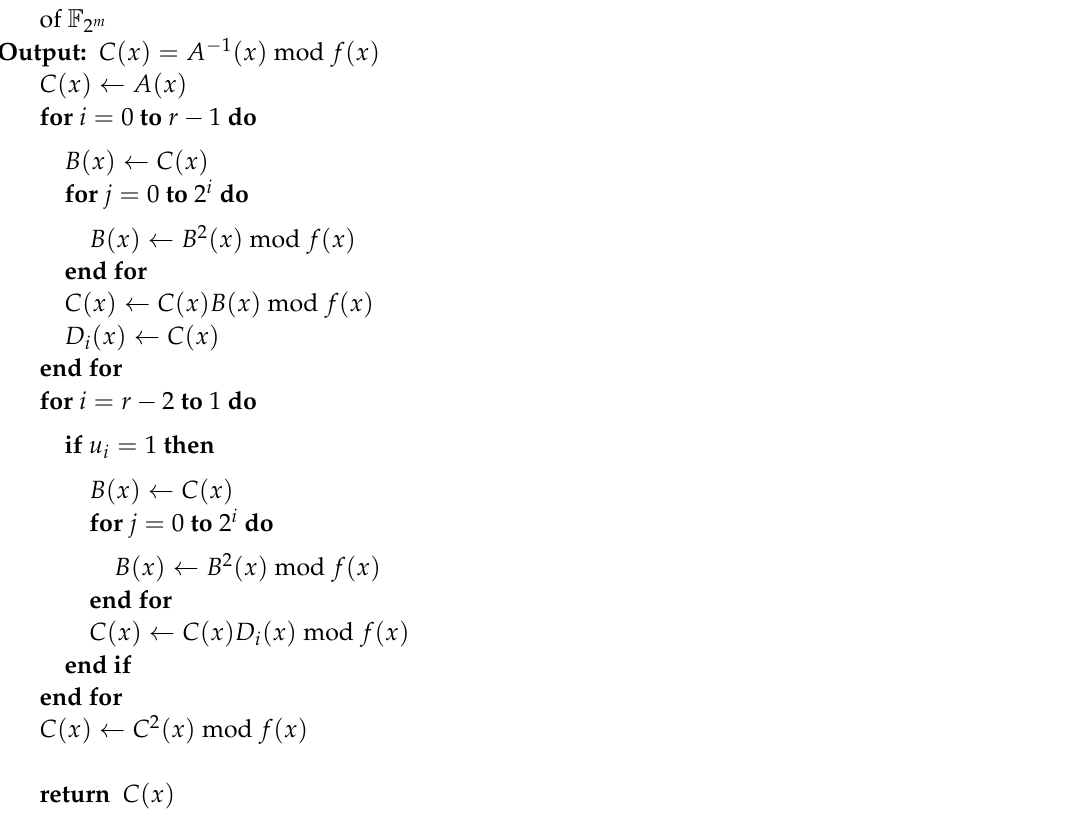
Algorithm 3 Itoh-Tsujii Inversion for Generic Binary Fields Where Extra Storage is